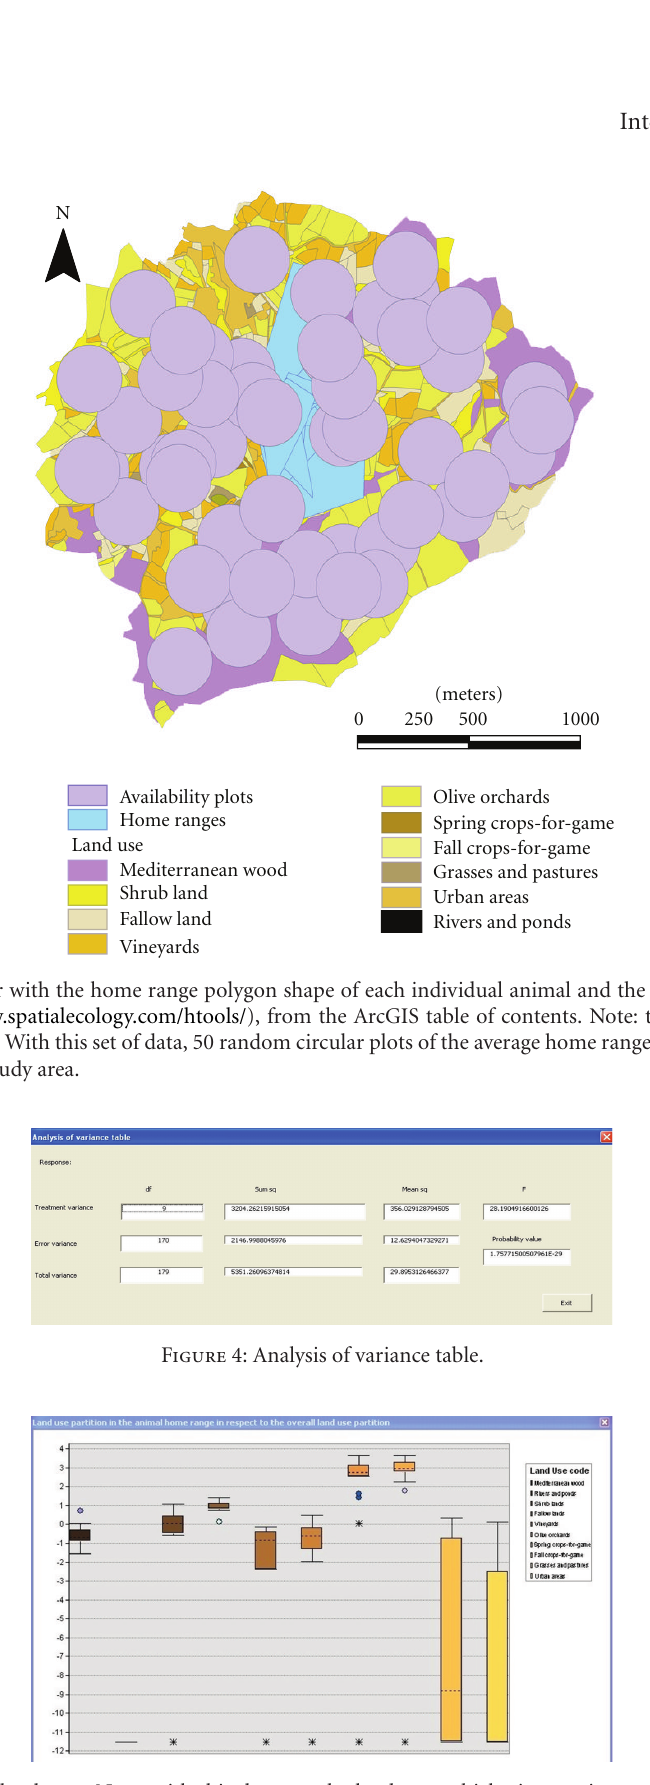
Figure 5: Box-plot graph of the land uses. Note: with this data set, the land uses which give maximum values of occurrence are “Spring crops-for-game” and “Fall crops-for-game.” The land uses which give the least uses are the “Rivers and ponds” and “Urban areas” ( P < 0 .